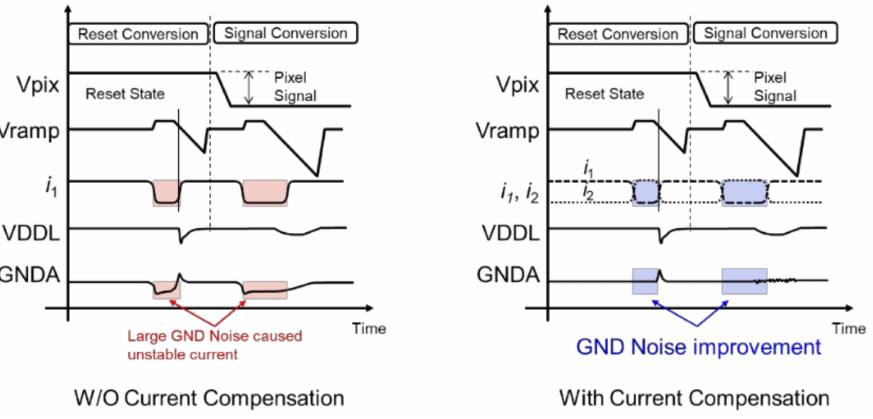
Figure 4. The impact of RUSH current